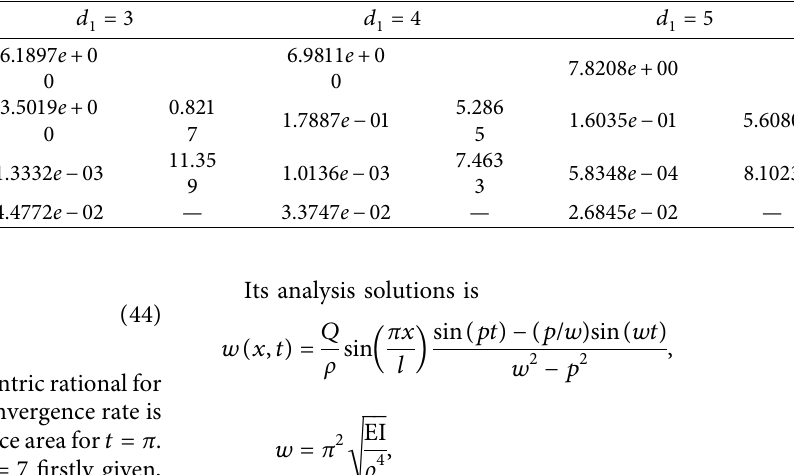
Table 12: Convergence rate of bending moment with quasi-equidistant nodes d